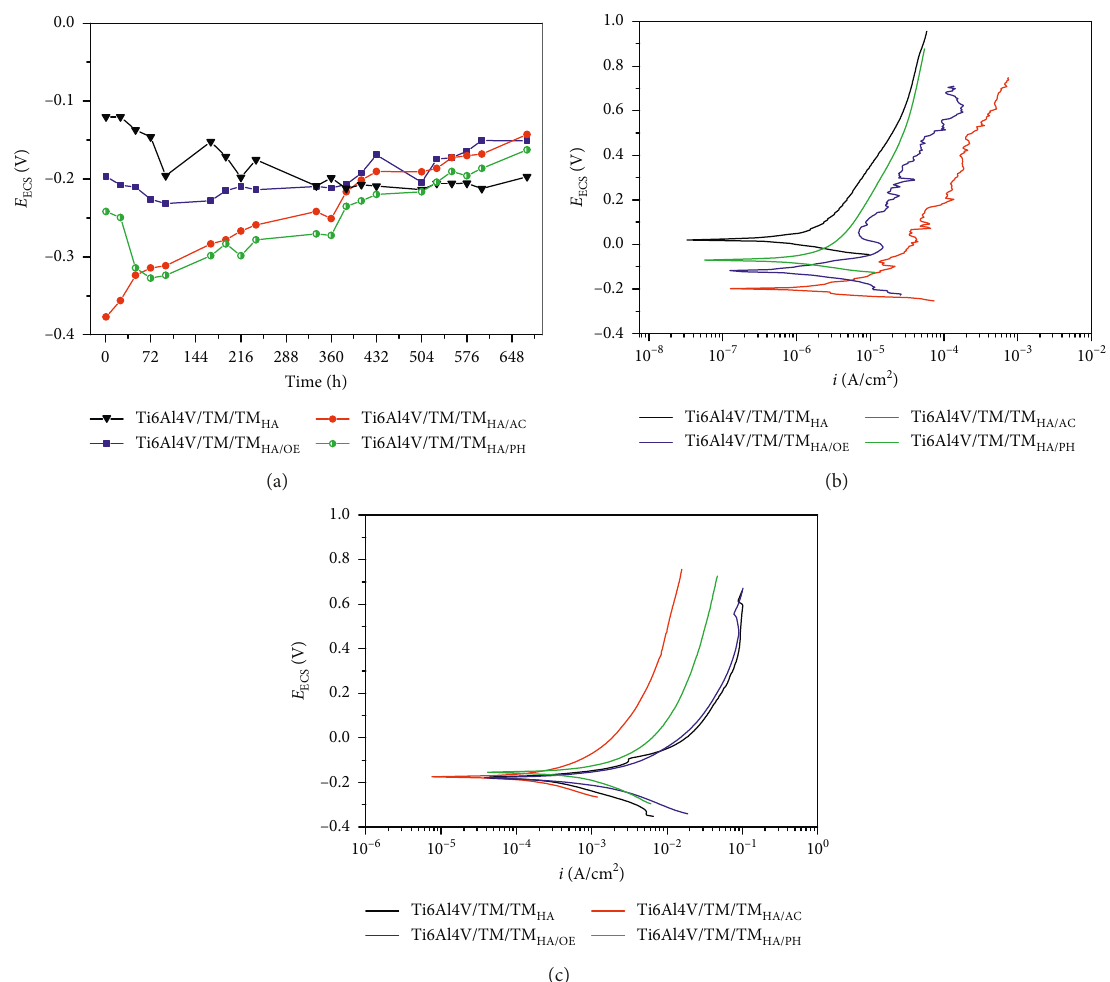
Figure 9: (a) Daily open circuit potential during 672hours of immersion; polarization curves after (b) 1 hour and (c) 672hours of coating immersion before and after sterilization processes in SBF at 37 ± 3 °